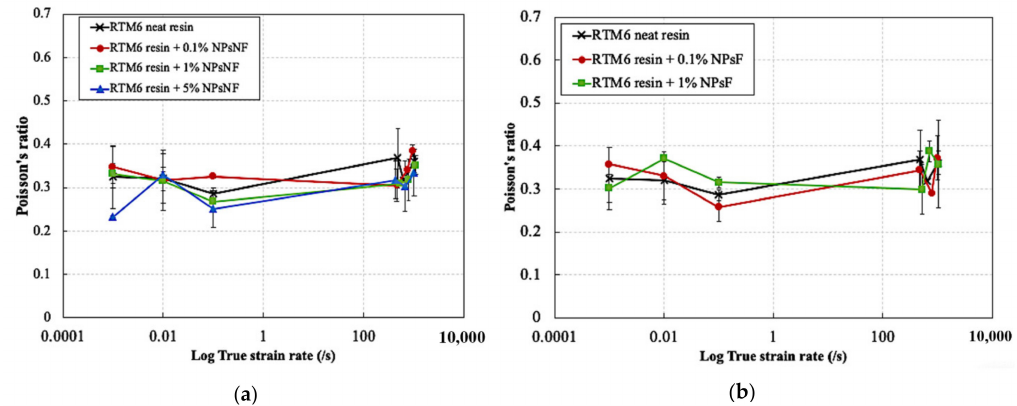
Figure 10. Effect of strain rate on the Poisson’s ratio of the silica nanoparticle-filled epoxy at different particle weight contents and functionalization conditions: ( a ) non-functionalized and ( b )